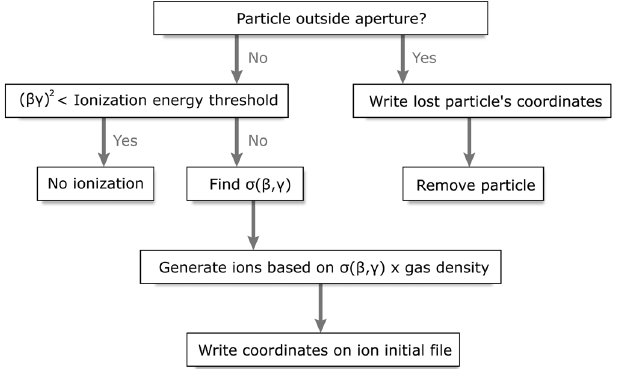
FIG. 6. Flow chart describing the ion generation algorithm used in this